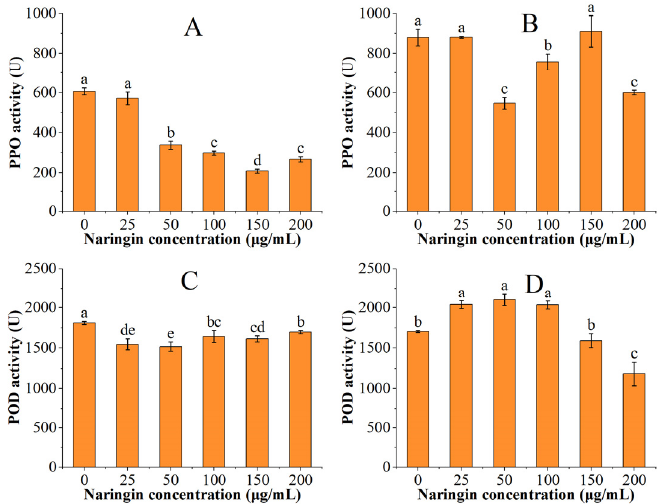
Figure 3. The PPO and POD activities of soybean sprouts. ( A ) PPO activity after 3 days of storage; ( B ) PPO activity after 6 days of storage; ( C ) POD activity after 3 days of storage; ( D ) POD activity after 6 days of storage. Bars with different letters indicate significant differences among the samples ( p < 0.05).